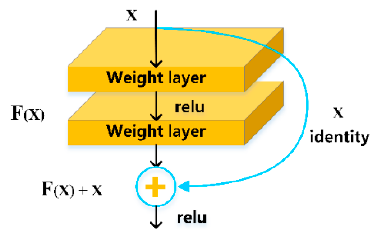
Figure 5. Residual learning: a building block.